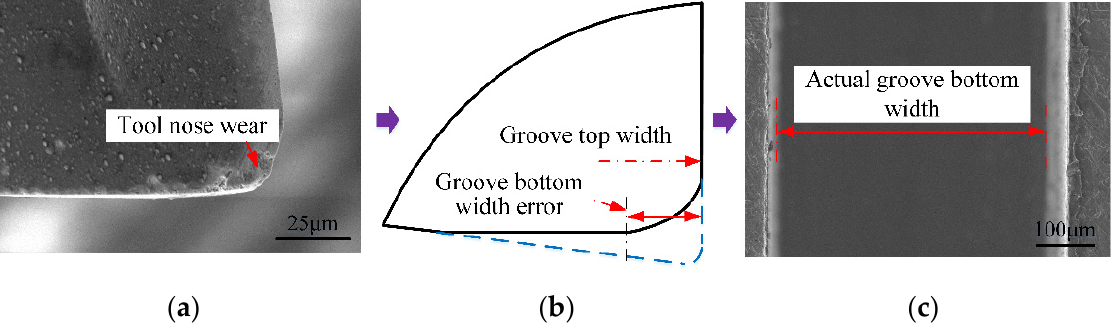
Figure 13. Worn out tool nose shape of carbide micromilling cutter and its influence on micro-groove size.